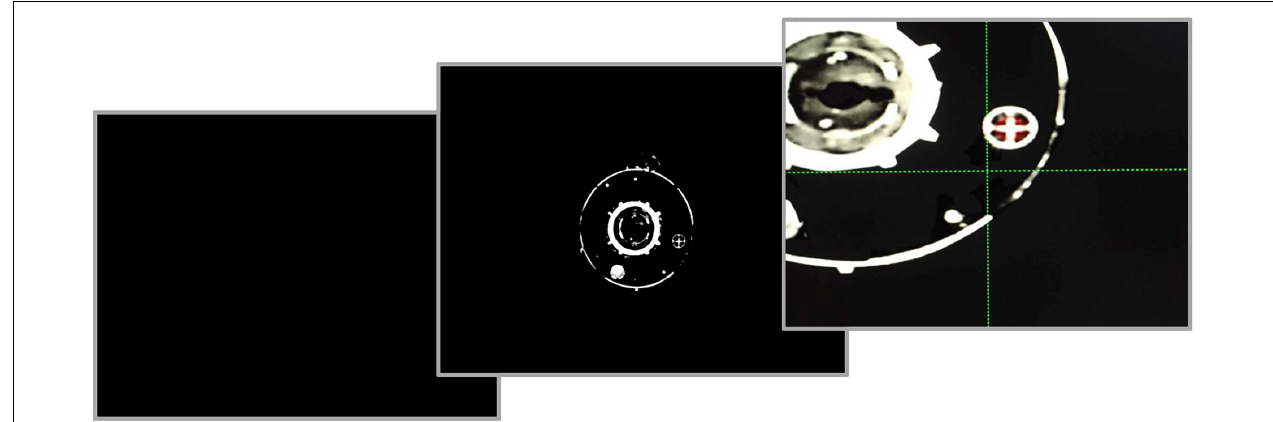
FIGURE 1 | The scene that participants saw on the monitor. When the spaceship was far from the space station, they saw nothing but darkness. When the spaceship gradually caught up with the space station, participants could see its outline. When the spaceship was near enough for docking, participants could see the mark for docking clearly. The dashed green cross is the location mark of the spaceship, and the white cross is the mark of the space station. When the intersection of the green cross was in the red circle within the white cross, the position deviation between those two aircrafts met the requirement for docking. The radius of the red circle was 23